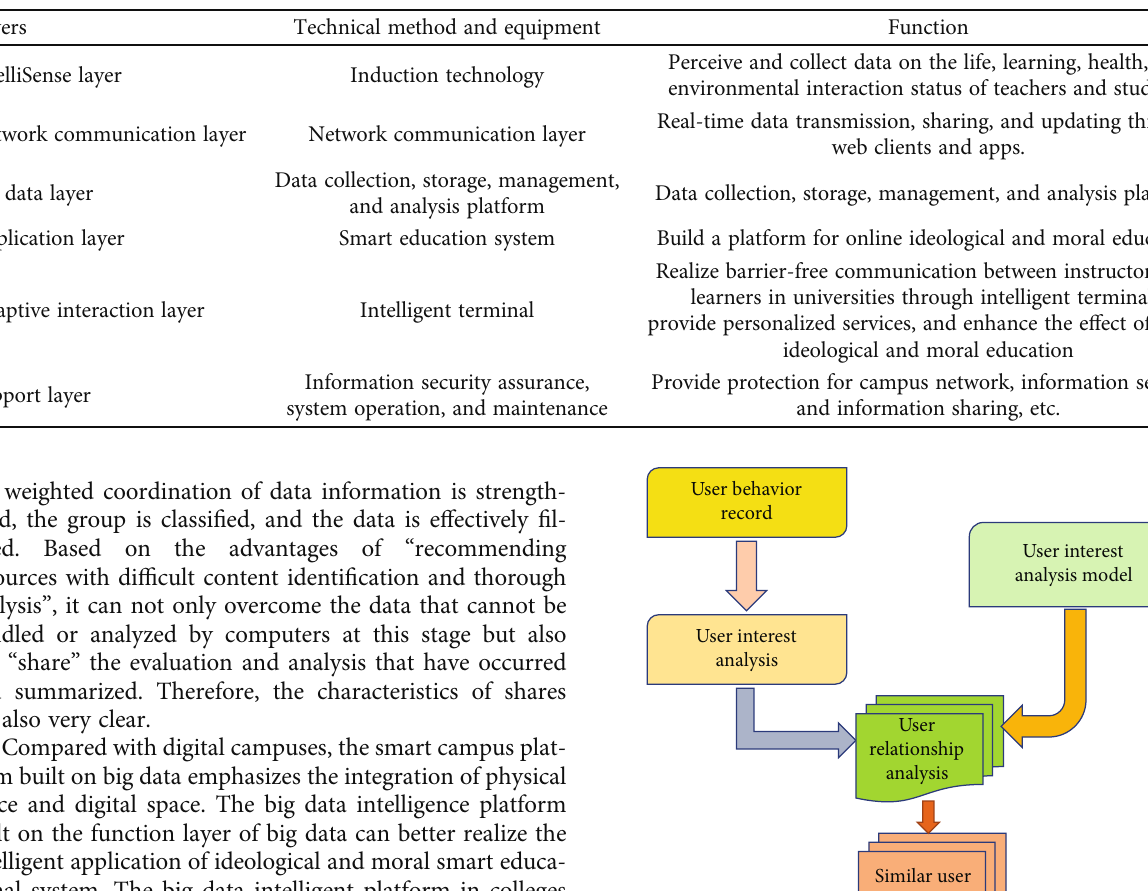
Table 1: Big data intelligent platform content.